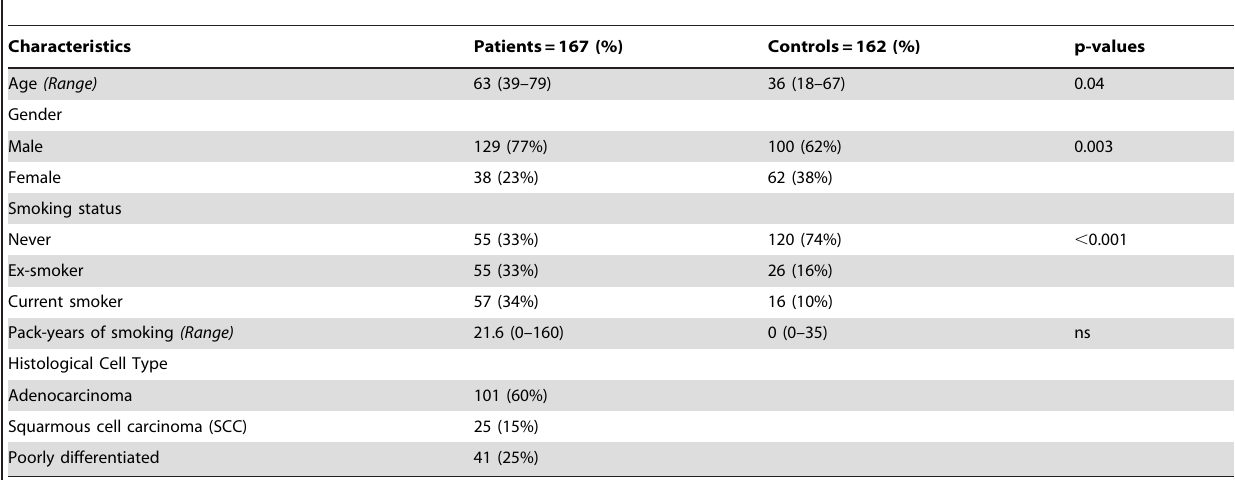
Table 1. Baseline characteristics of Lung cancer patients and controls.